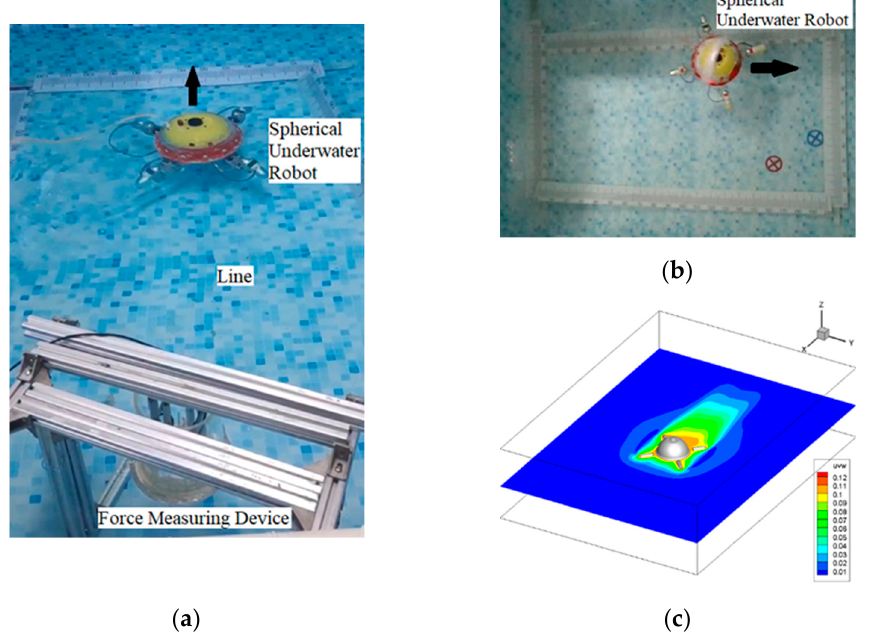
Figure 10. Experiment and simulation scenes. The black arrows represent the direction of the robot moving. ( a ) The propulsion force measurement; ( b ) The robot moving under water; ( c ) The simulation.